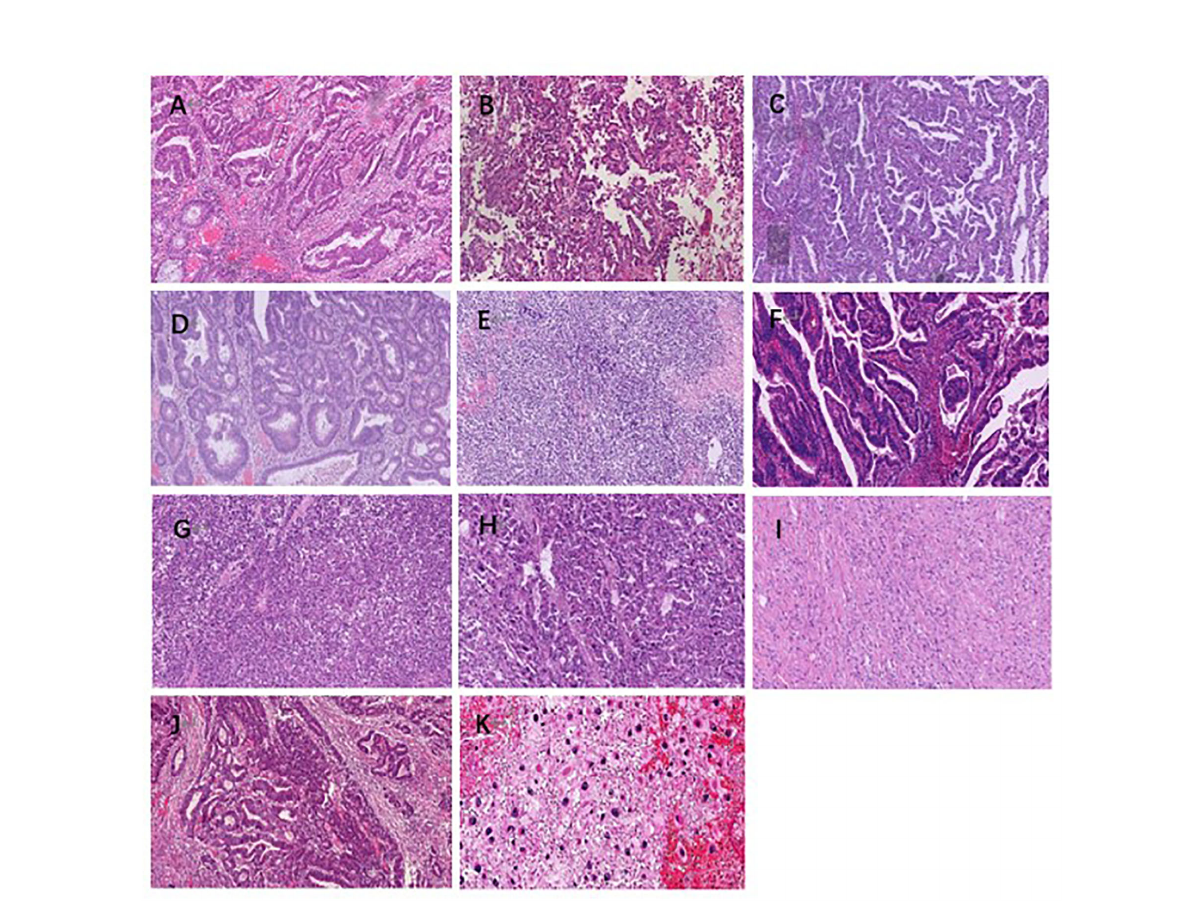
FIGURE 1 Case 1-4 HE staining diagram, 10x10. (A) : Case1 moderately differentiated adenocarcinoma of the rectum; (B) : Case1 uterine clear cell carcinoma in the pelvic region; (C) : Case1 clear cell carcinoma of the uterus metastasized to the right lower abdomen; (D) : Case2 well differentiated intramucosal carcinoma of the transverse colon; (E) : Case2 poorly differentiated carcinoma of bladder; (F) : Case3 moderately differentiated adenocarcinoma of the rectum; (G) : Case3 right adrenocortical carcinoma; (H) : Case3 intraperitoneal metastasis of adrenocortical adenocarcinoma; (I) : Case3 pleomorphic sarcoma on the right chest wall (J) : Case4 colon moderately differentiated adenocarcinoma; (K) : Case4 histiocytic sarcoma of the right upper arm.